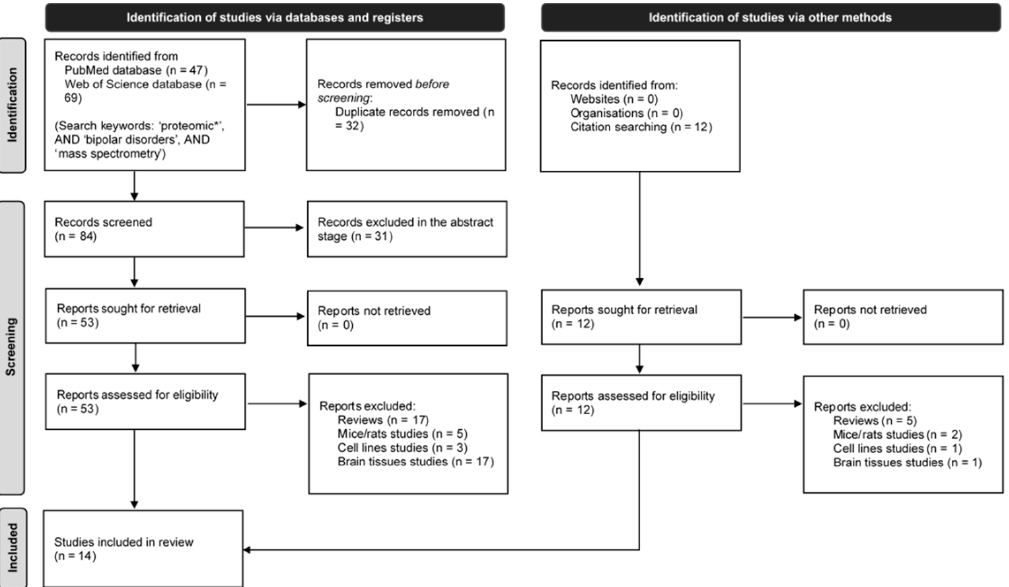
Figure 1. Flow diagram of the selection process of the studies included in the systematic review, following the directives of PRISMA 2020 [61] .